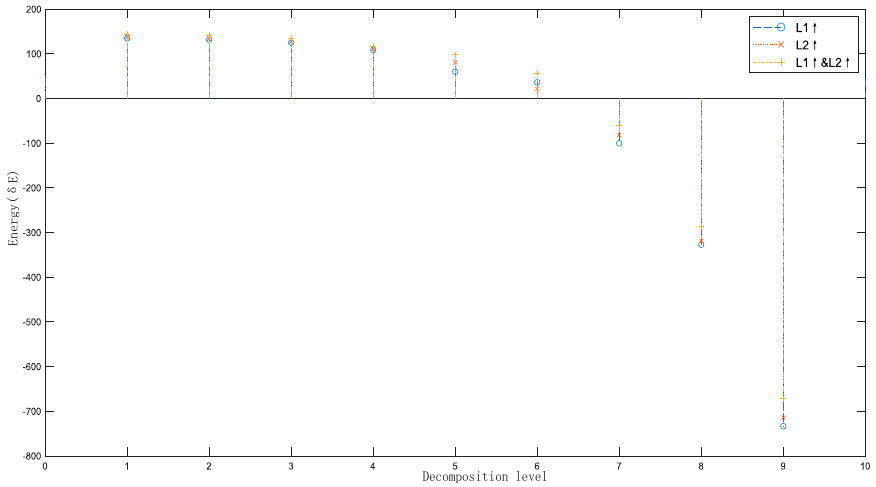
Figure 6. The distinction between normal condition and recessive